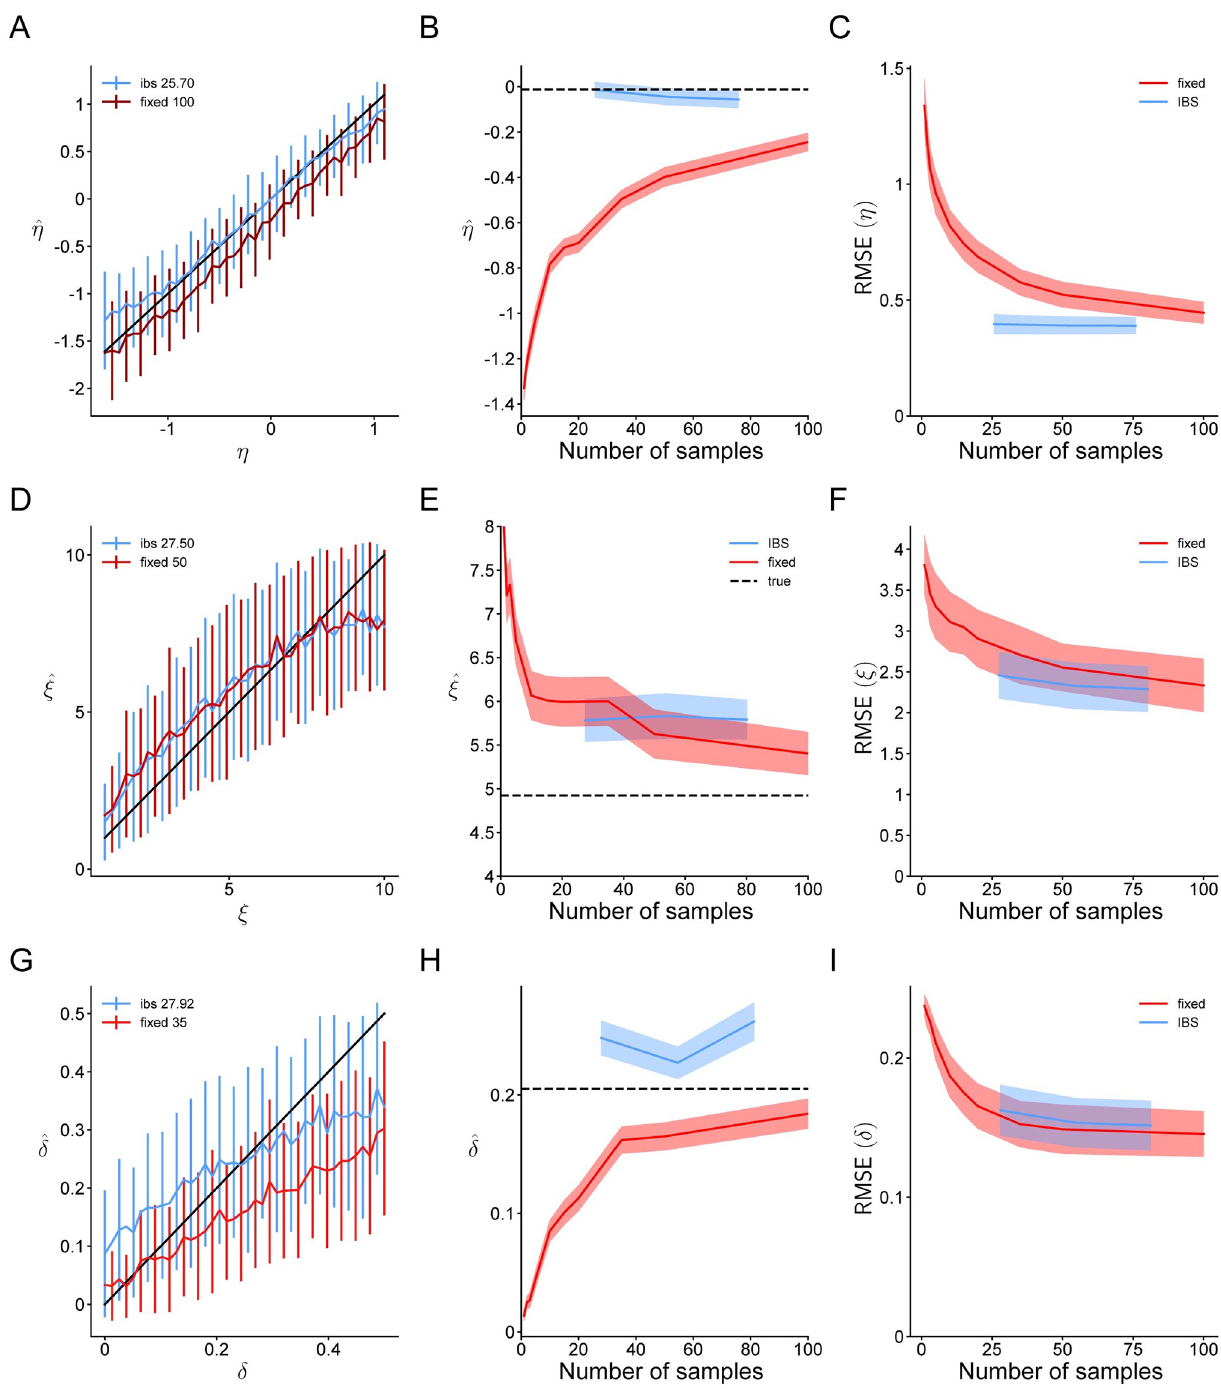
Fig 9. Parameter recovery for the four-in-a-row model. Same as Figs 5 and 7, for the 4-in-a-row experiment and estimates of the value noise η � log σ , pruning threshold ξ and feature drop rate δ . In panel A we show results for R = 1 and M = 100; in panel D , R = 1 and M = 50; in panel G , R = 1 and M =